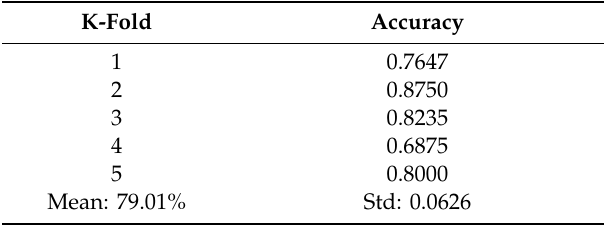
Table 3. Accuracies achieved by performing 5-Fold Cross-Validation on the RF